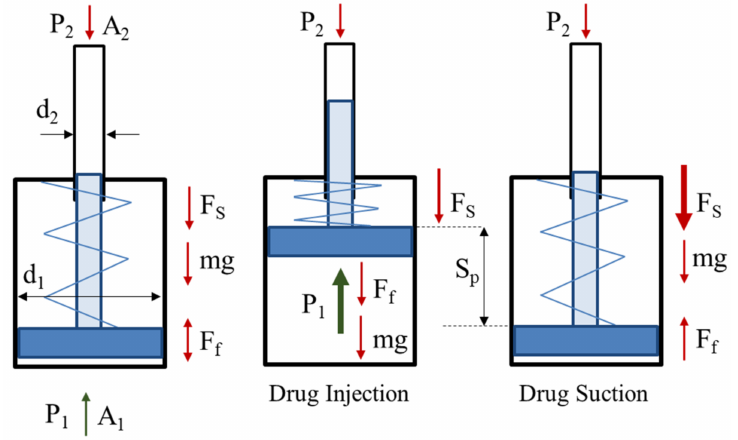
Figure 4. Force balance over the piston plunger of the needle-free jet injector.